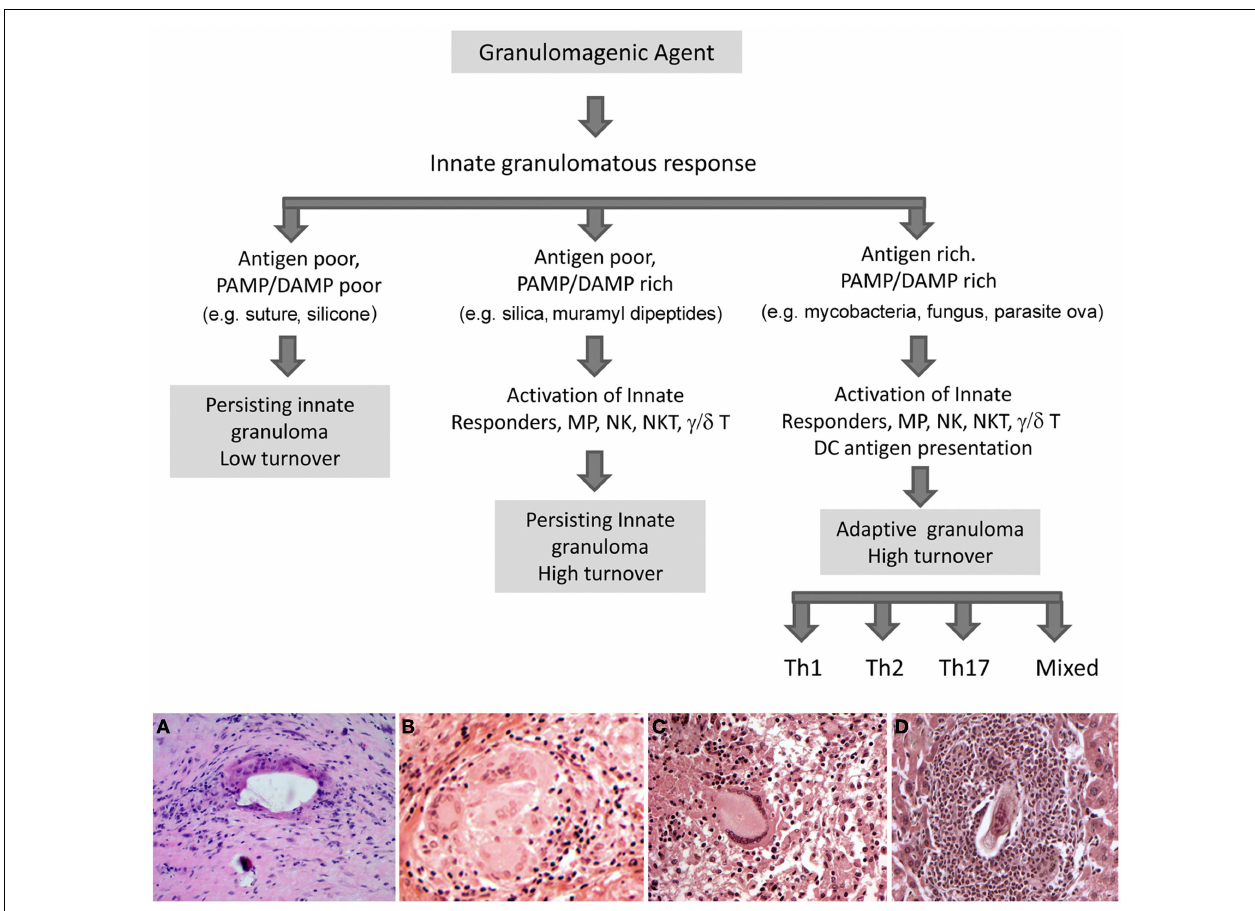
antigen-specificT cell responses resulting in a complex high turnover granuloma.The types of cellular components will depend upon the participatingT cell subset. Examples would be mycobacterial, fungal, and parasite ova elicited granulomas. It should be noted that humoral elements including antibodies and complement may also influence lesions. Lower panels show examples of the histologic appearance of the various granulomas. (A) Innate low turnover foreign-body granulomatous response to surgical bone cement; (B) Innate high turnover granulomatous response to silica; (C) Adaptive granulomatous response to M. tuberculosis ,Th1 type; (D) Adaptive eosinophil-rich, granulomatous response to schistosome parasite egg,Th2 type. Original magnifications 200 ×